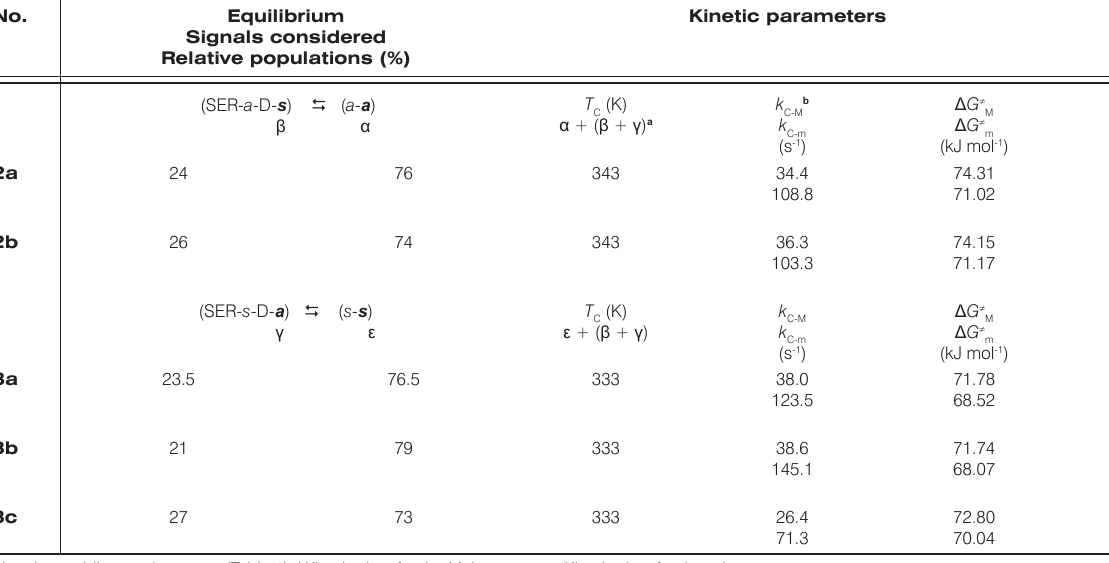
Table 5. Kinetic parameters deduced from VT 1 H NMR of compounds 2a , 2b and 3a - c for rotation of the “ closed-chain ” D ( ax or eq ) N -ligand (see Scheme 4).